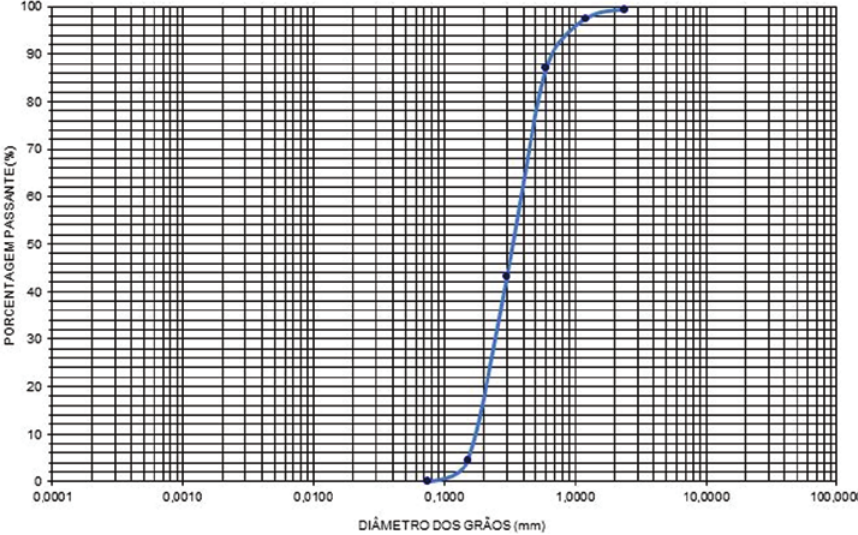
Curve aggregate granulometric